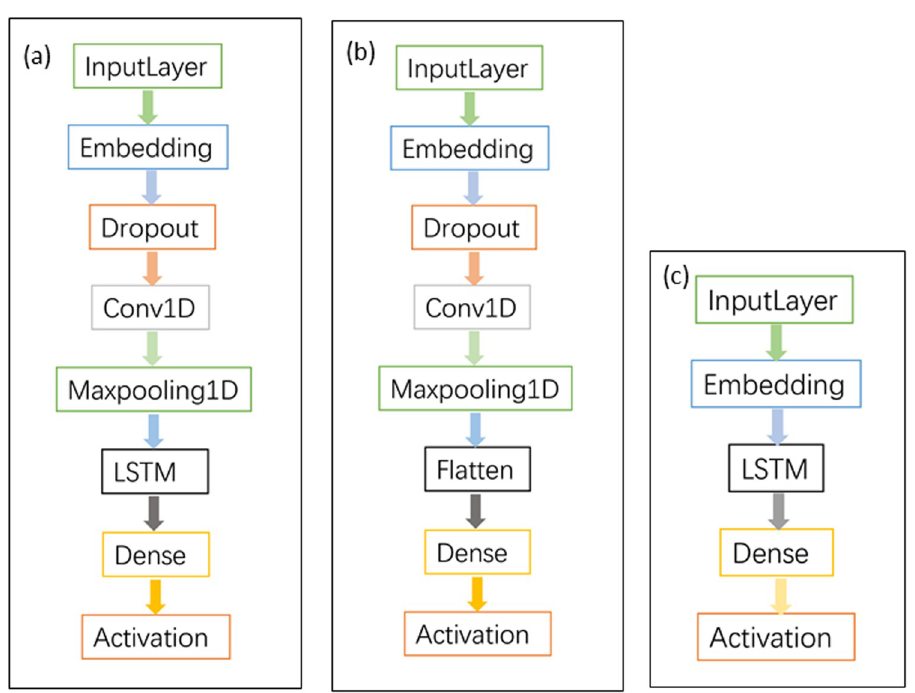
Fig 5. Structure of the three neural networks. (a) CNN_LSTM-based network. (b) CNN-based network. (c) LSTM- based network.